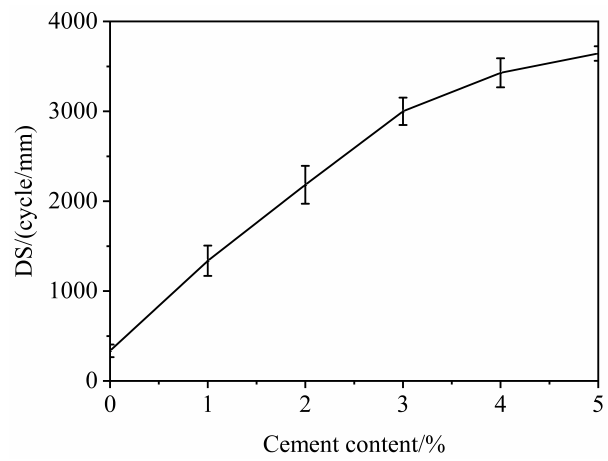
Figure 2. Results of rutting test.